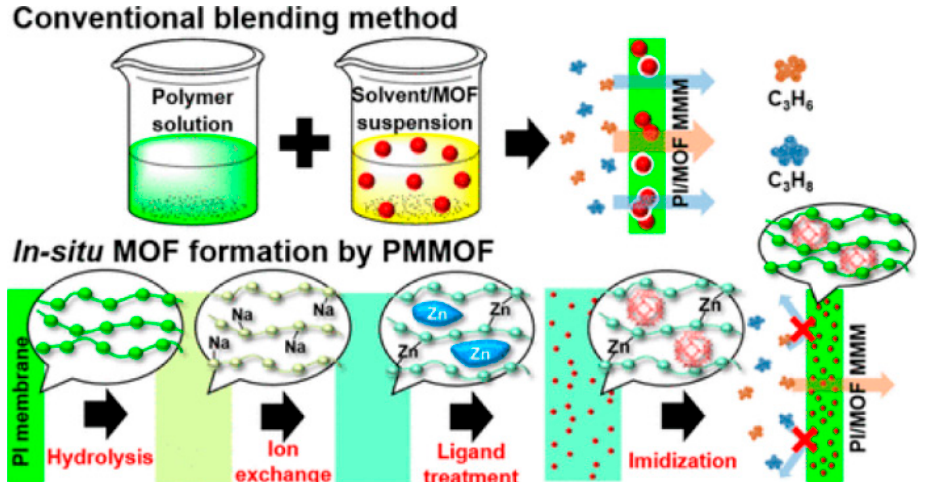
Figure 9. Schematic image of the in situ formation of metal organic framework (MOF)-doped MMMs [77].